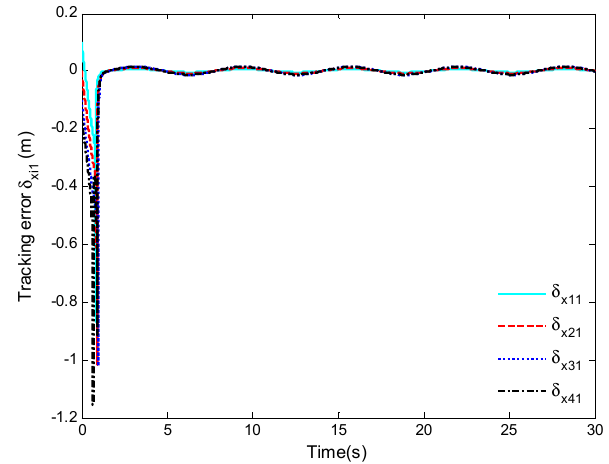
Figure 11. The curves of tracking error δ xi